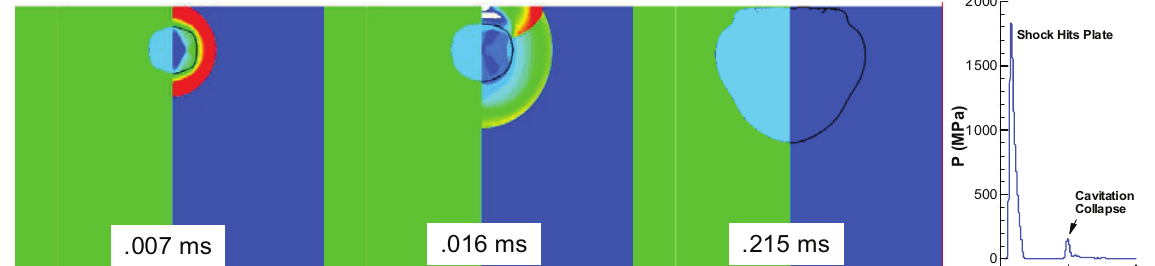
Fig. 16. Flow field for a stand-off of 1 cm and depth of 4 cm.